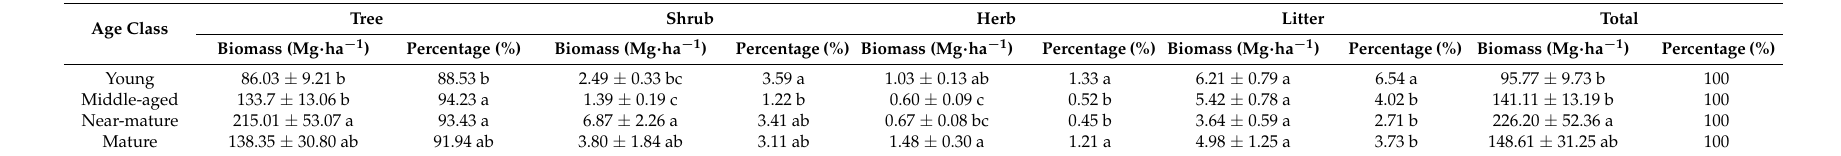
Table 4. Biomass and the distribution of Quercus variabilis natural